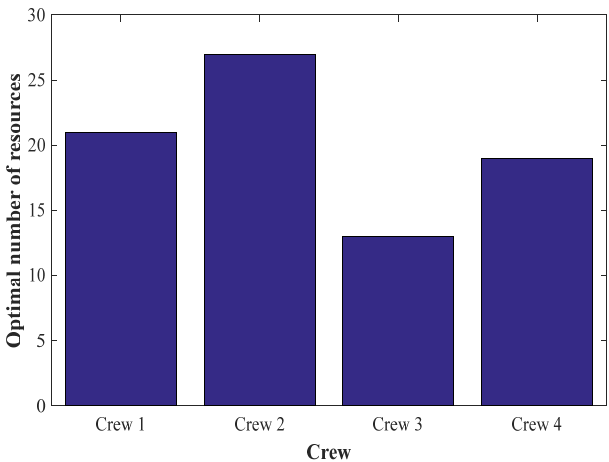
Figure 12. The optimal number of resources is assigned to each crew in the 66 bus case. Table 7. The optimal priority list of the damaged components in the 66 bus case.